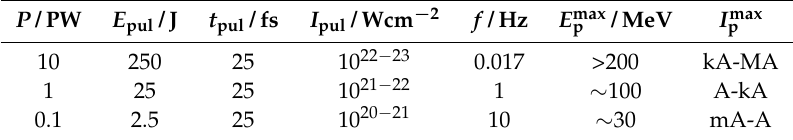
I max p / MeV p 100 A-kA ∼ 30 ∼